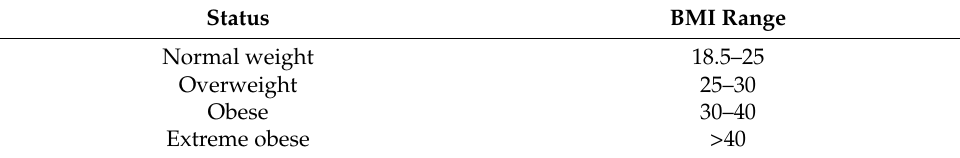
Table 2. Categories of